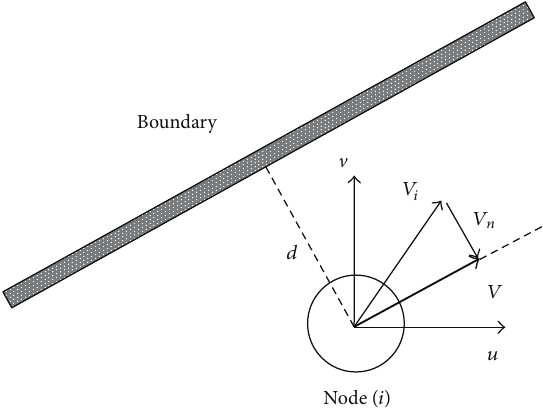
Figure 2: Object surface boundary